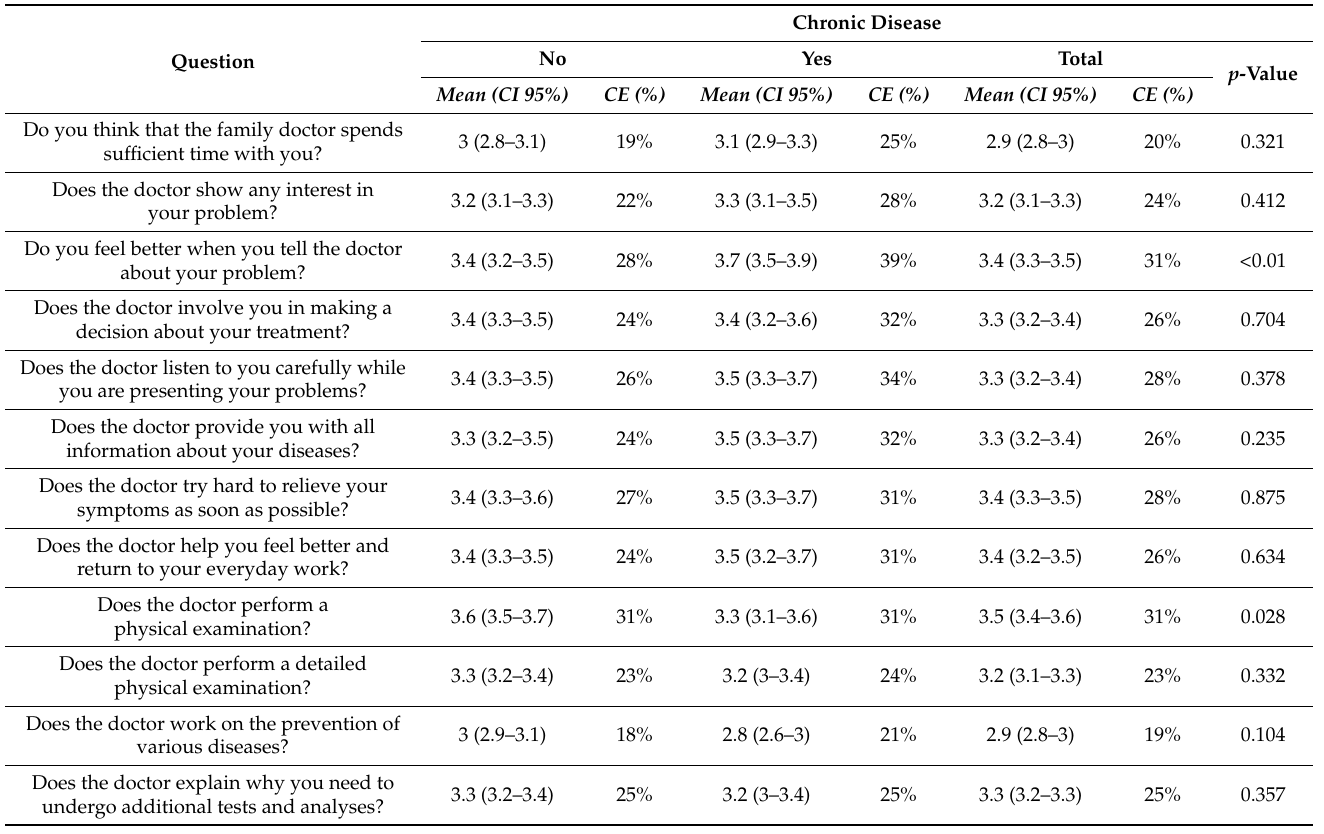
Table 3. Satisfaction with health care in the adult population of the Federation of Bosnia and